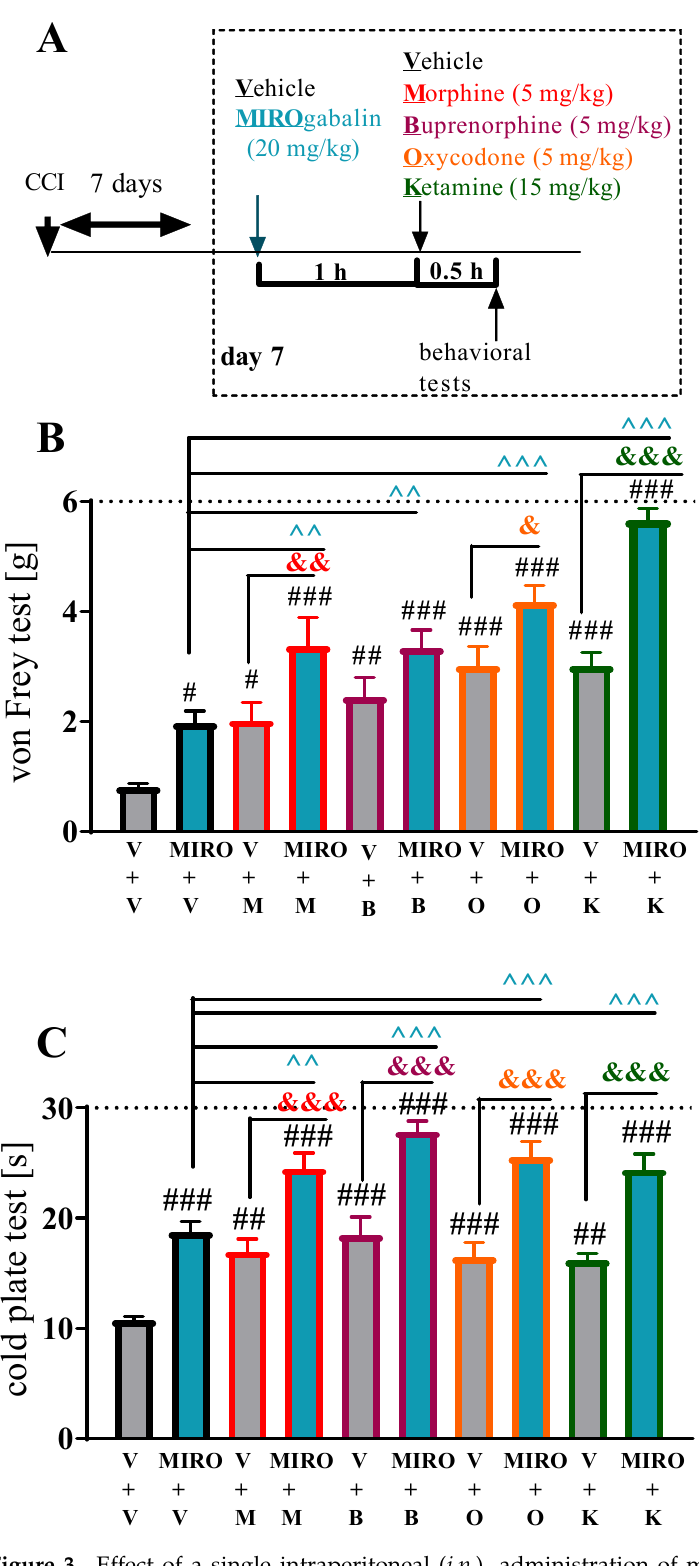
both tests (Figure 3B,C).